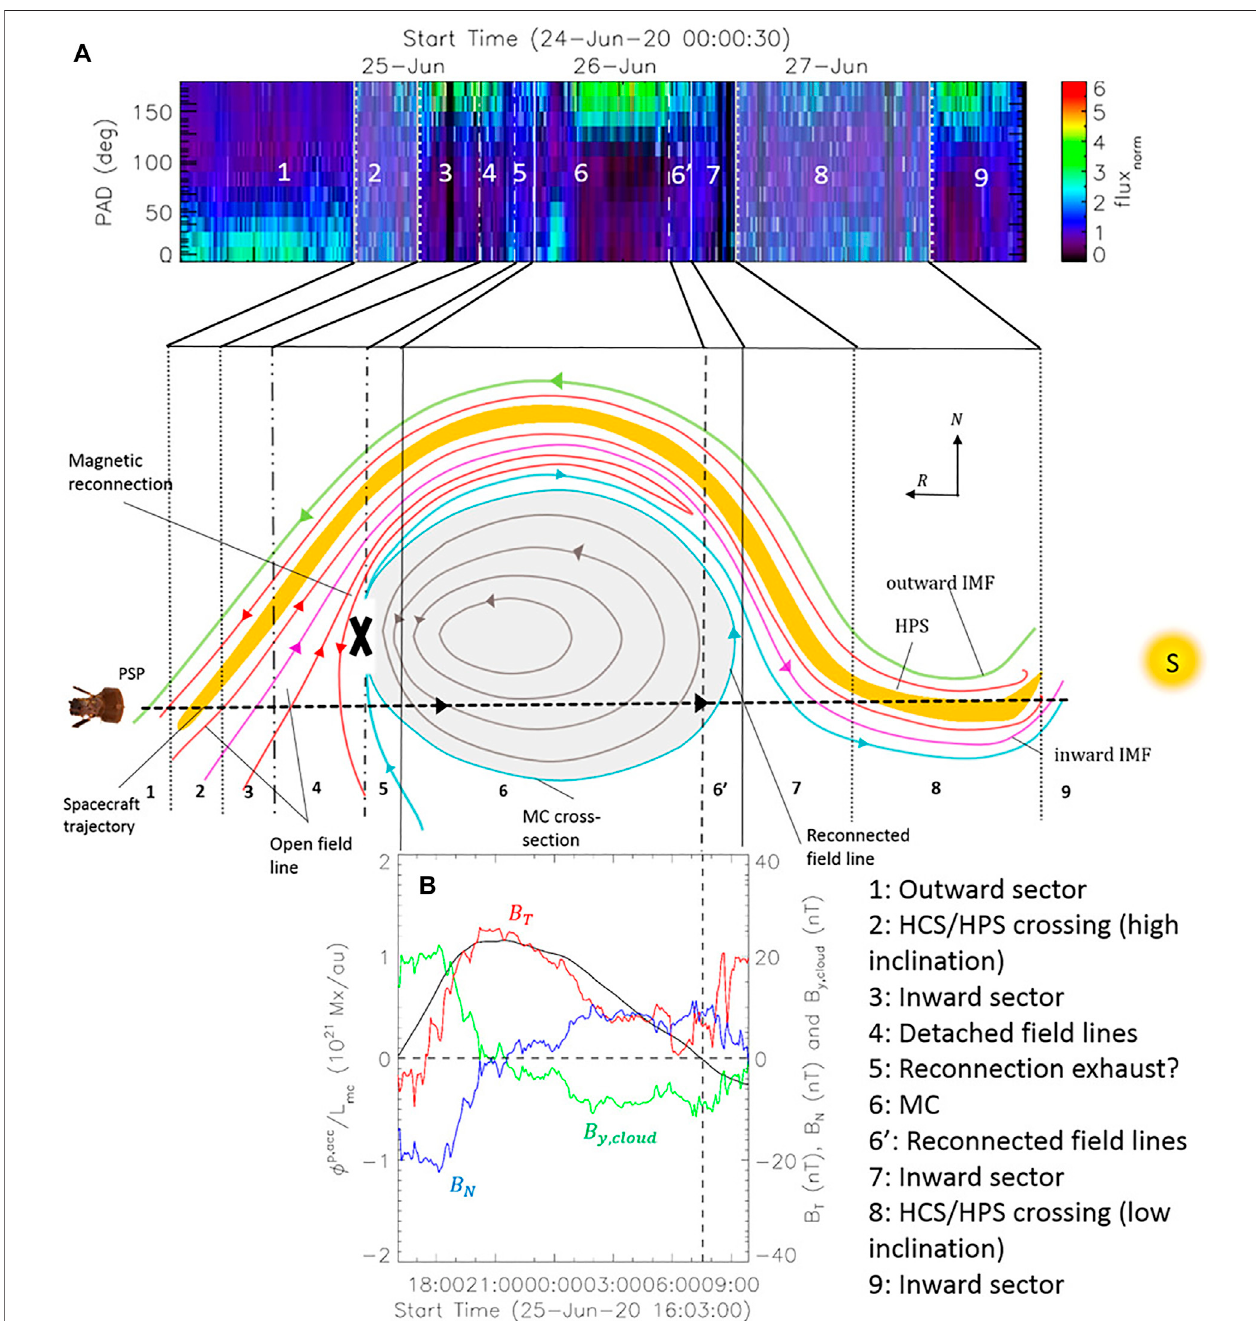
FIGURE6|(A) ThePAD ofthenormalizedsuprathermal electron fl uxduring 24 – 27June 2020and aschematic (nottoscale) showing theMCcross-section(grey) and adjacent interplanetary structures as observed by PSP. The regions 1 – 9 are indicated on the plots. The inward and outward IMFs connected to the solar origin are shown in purple and green, respectively. IMFs indicated in red and cyan correspond to open fi eld lines disconnected from their solar origins and reconnected with MC, respectively.TheHCS/HPSisshowninyellowandthePSPpropagationpath(intheFRframeofreference)isshownindashedblackline. (B) Thetimedistributionof accumulated azimuthal fl ux ( ϕ p , acc / L mc ), azimuthal fi eld line ( B y , cloud ) and magnetic vectors ( B N , B T ). The dashed line indicates t out * .